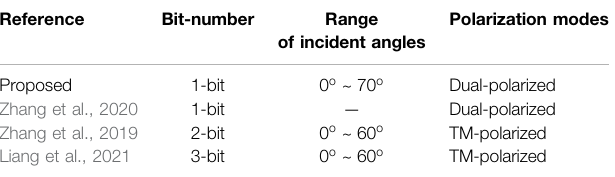
Figure 2B is the corresponding amplitude characteristics.